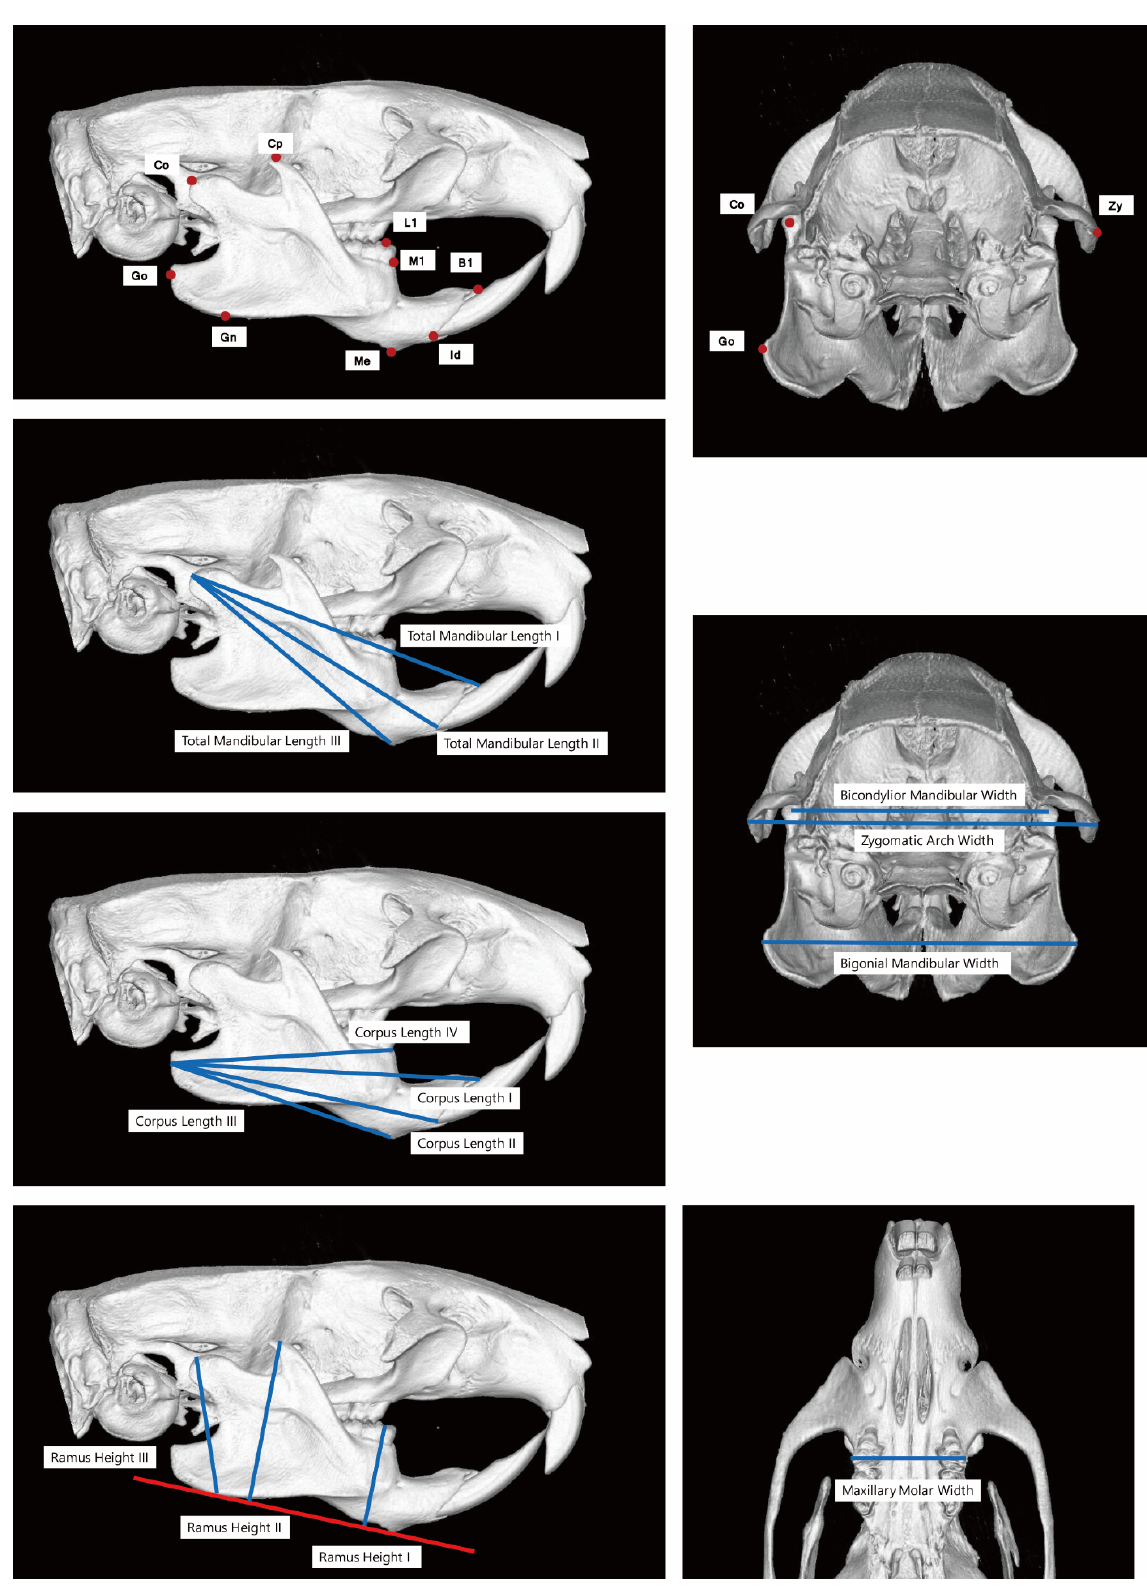
Figure 5. Measurements in mCT images. The definition of each landmark are shown in Table 2.